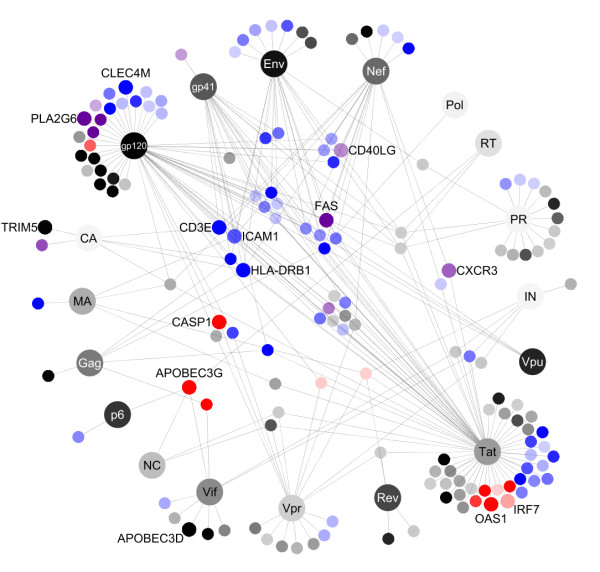
HIV-human protein interaction network. Viral proteins are represented by the largest dots. The lightness of each dot indicates the rank of relative evolutionary rates of the viral proteins with dark colors representing a high rank and light colors representing a low rank. Host proteins are represented by smaller dots positioned among the interacting viral proteins. Nodes of the host factors discussed in the text are enlarged. Colors indicate the functional group to which the factors belong: blue - membrane-related proteins, red - innate immune response proteins, magenta - both. The intensity of the colors indicates the positive selection score in the site-based scoring with stronger colors representing a high rank and less intensive colors representing a low rank. Only host proteins with significant LRT in the comparison of the four primates are shown. The network was rendered using Cytoscape [77].